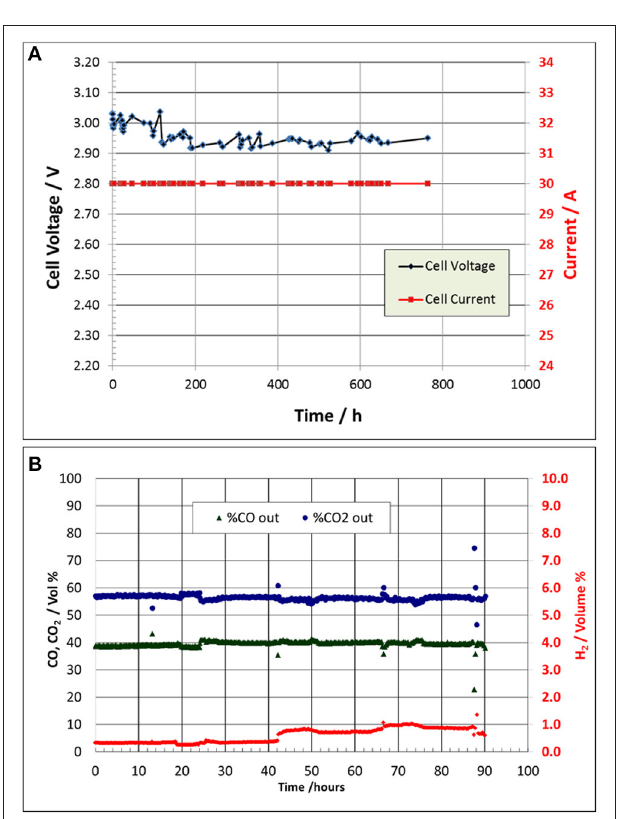
FIGURE 8 | The 250 cm 2 cell performance at DM showing stable voltage operation for about 760h until shutdown is shown in (A) . The 250 cm 2 CO 2 operation at LanzaTech shows the cell catholyte output GC gas composition analysis in an extended performance 90h test run is shown in (B) .